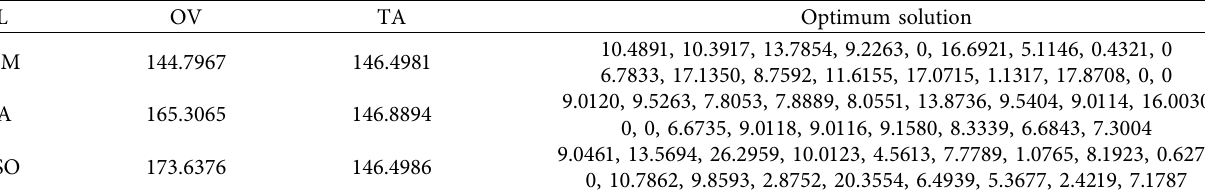
Table 6: Optimal results of the expected value model.